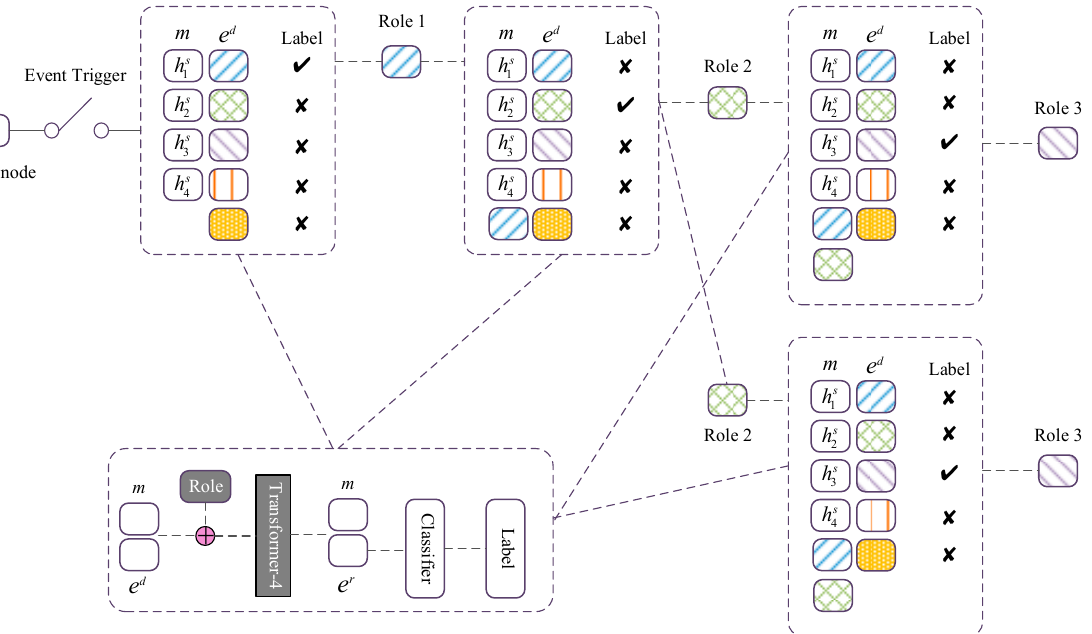
Figure 5. The overall workflow of event path expanding. For a triggered event, to enable the awareness of the current path state, history contexts and the current event role, we first concatenate the memory tensor m and the entity tensor e d , then add them with a trainable event role indicator embedding, and encode them with the fourth Transformer module, TF-4, to facilitate the context- aware reasoning. Finally, we extract the enriched entity tensor e r from outputs of TF-4 and stack a linear classifier over e r to conduct the path-expanding